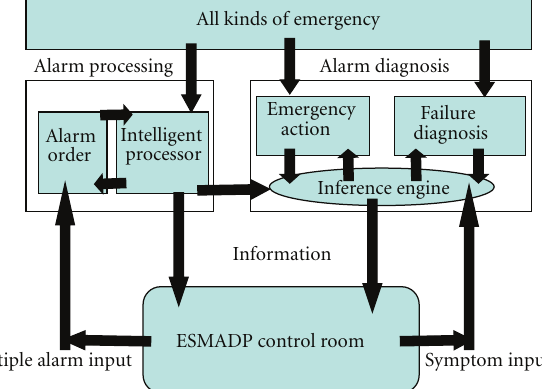
Figure 7: The functional structure of